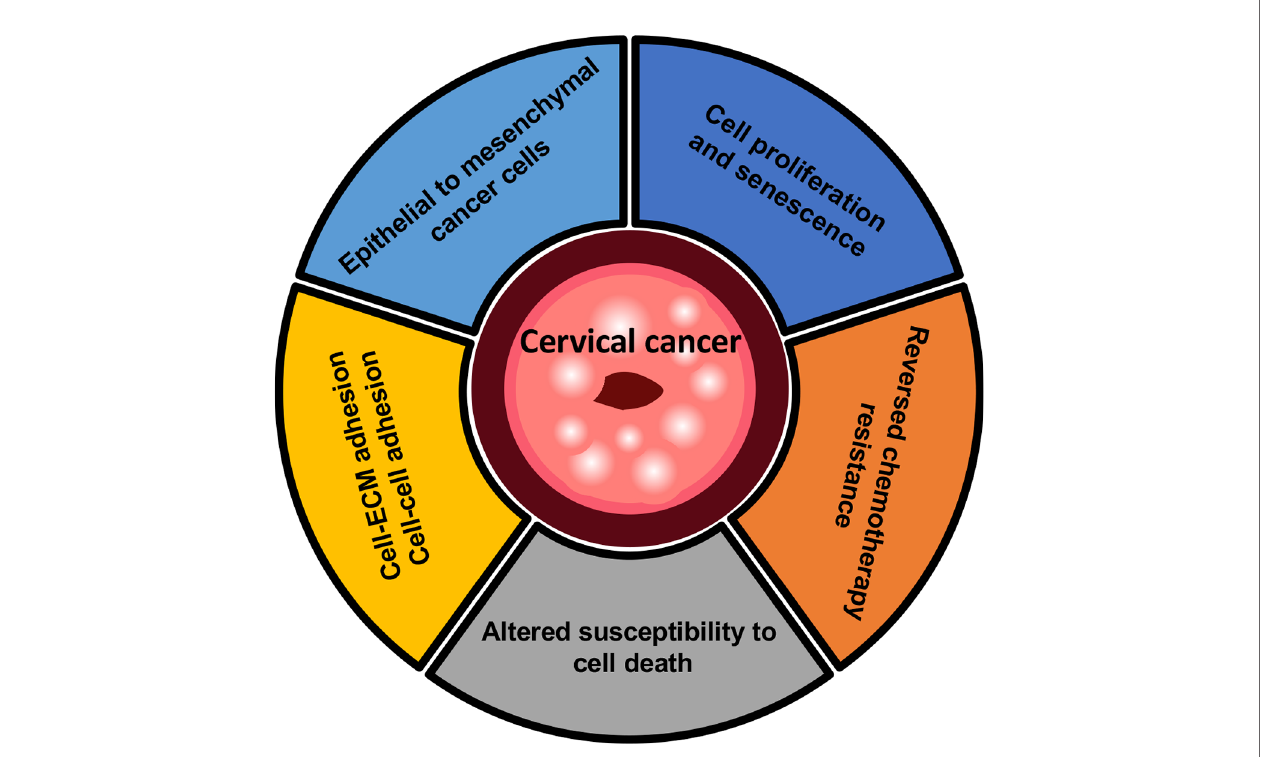
FIGURE 3 | Overview of mechanisms in cervical cancer. Cervical cancer cells have been proposed to permit rapid proliferation and activate an epithelial- mesenchymal transition (EMT) program. Cell-ECM or cell-cell adhesion which are known to occur during metastatic tumors, and lead to the subsequent changes in the crosstalk of cancer cells with neighboring microenvironment. In the context of cell death, the inhibition of glycan-processing enzymes provides the potential strategy of chemotherapy drugs with drug-resistant cervical cancer, notably involving the regulation of apoptosis during platinum-based